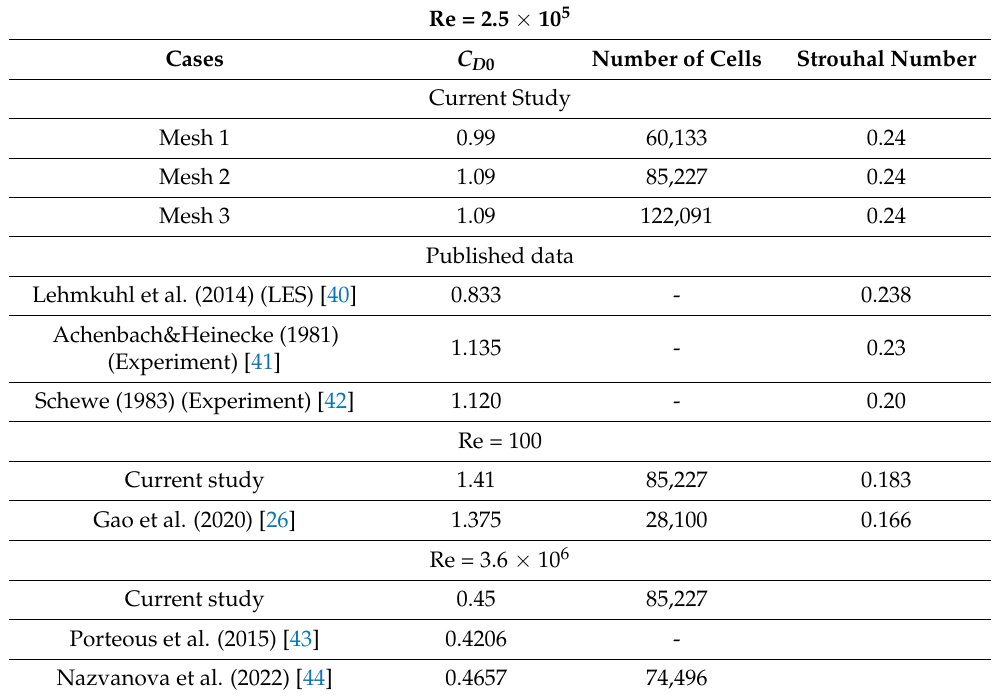
Table 1. Mesh independence test results, compared to